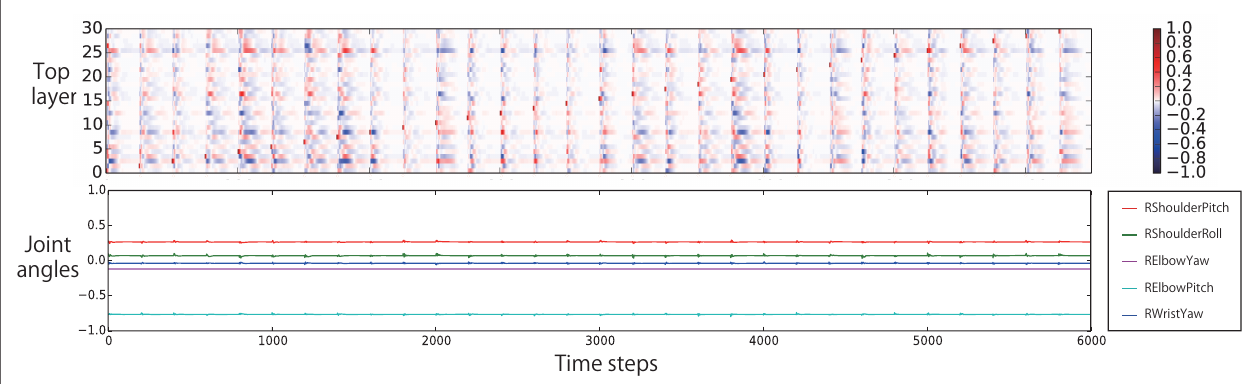
FIGURE 11 | After behavior generation, instead of giving an subsequent instruction, we added a small perturbation ( + 1.0) to every neural unit in the top layer every 200 time steps (indicated by orange dots) . The top panel shows the difference of the internal states computed with the values of the fixed point. White-colored cells correspond to the values of the fixed point. Though the perturbations spread throughout the layer once, the internal states converged again. As shown in the bottom panel, the output joint angles that keep the waiting posture were little influenced by the perturbations.